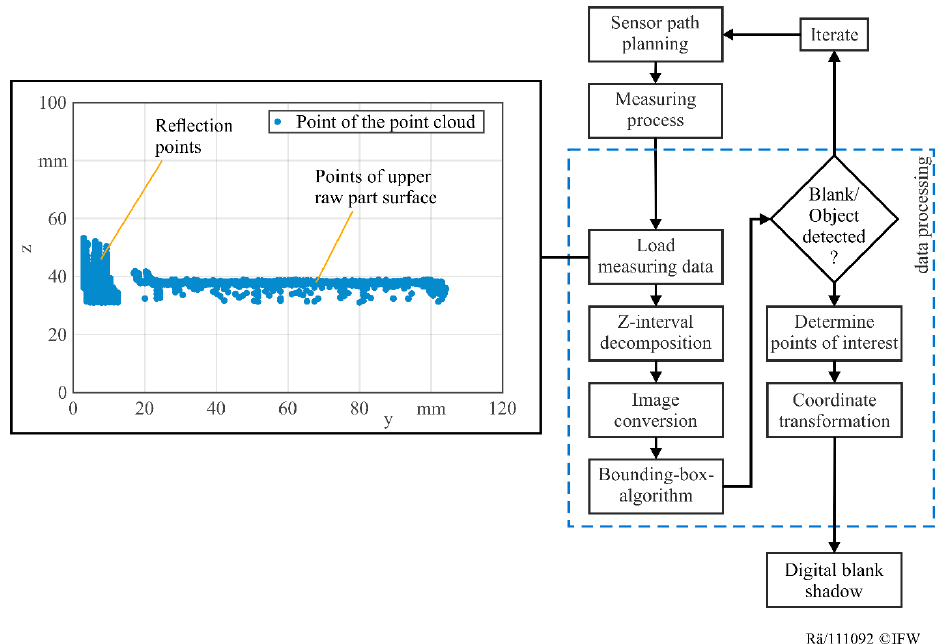
Figure 6. Flow chart of the data processing.